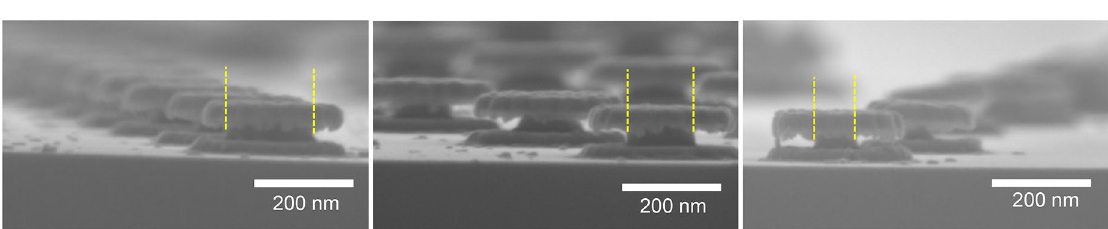
Figure 6. ( a ) Schematic configuration of conventional metal–insulator-metal (MIM) nanodisc and its extinction efficiency spectra from DDA simulation, cross-sectional view of E-field intensity and magnetic field distribution in the x–z plane across the disc center calculated at the spectral position of magnetic mode using FDTD method. ( b ) Schematic configuration of VCB nanodisc and its extinction efficiency spectra from DDA simulation, cross-sectional view of E-field intensity and magnetic field distribution in the x–z plane across the disc center calculated at the spectral position of magnetic mode using FDTD method. The incident light is assumed to be polarized in the x-direction.